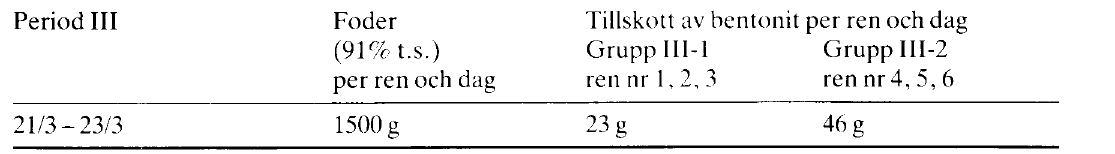
Table 3. Consumption of feed and supplements of bentonite during period III.